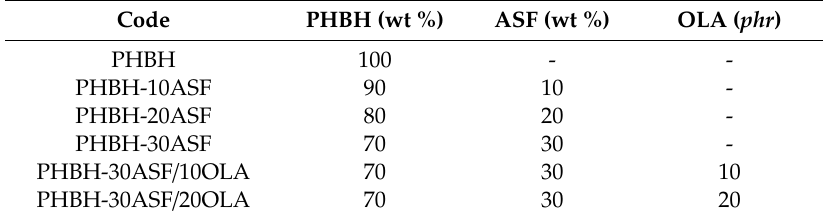
Table 1. Summary of sample compositions according to the weight content (wt %) of PHBH (Poly(3-hydroxybutyrate- co -3-hydroxyhexanoate)), and ASF (Almond Shell Flour) and the addition of OLA (Oligomeric Lactic Acid) as parts per hundred resin ( phr ) of PHBH-ASF composite. Code PHBH (wt %) ASF (wt %) OLA ( phr )